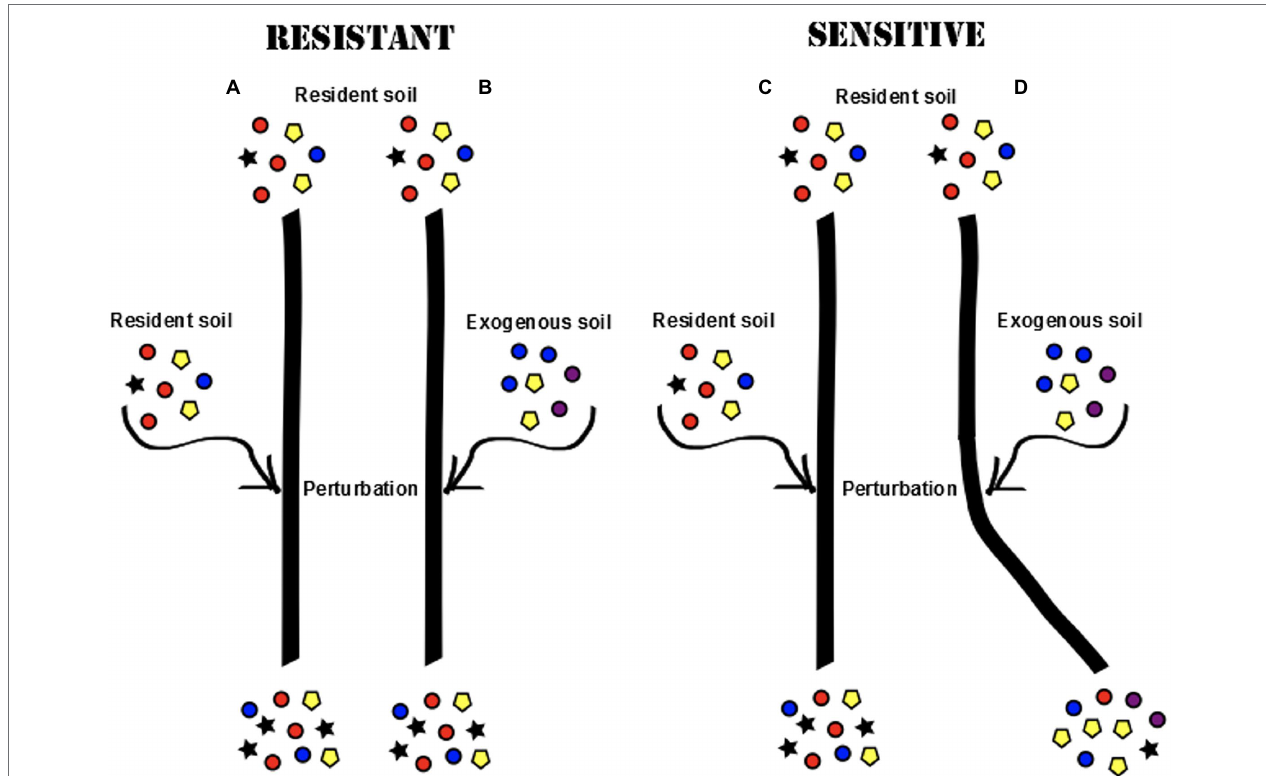
FIGURE 2 | Different root microbial communities may develop in the plant roots if the initial community is resistant or sensitive to perturbation (colors represent different microbial taxa). In a resistant community, the progression of community development would continue in the same direction regardless of exposure to an exogenous soil (A,B) . In a sensitive community, the introduction of an exogenous soil would cause a shift in community composition (C,D)